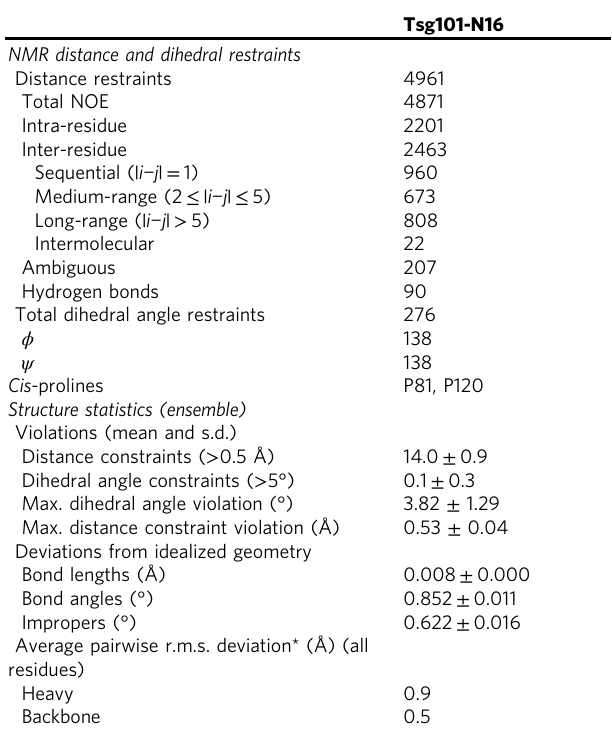
Table 1 NMR structure re fi nement statistics